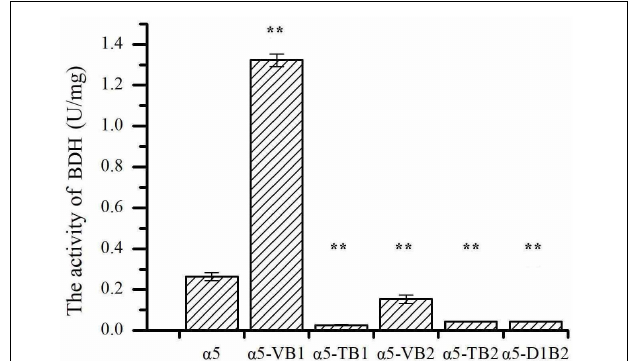
FIGURE 3 | The specific activities of 2,3-butanediol dehydrogenase (BDH). Data represent the mean of three independent biological replicates. Error bars represent the SD of the average values. Statistical significance is denoted as ** P < 0.01 and ** P <